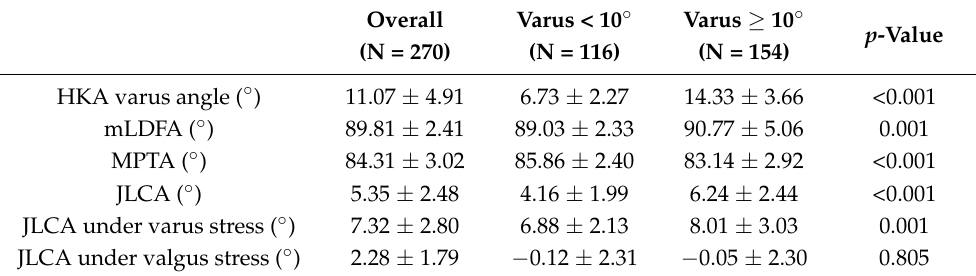
Results are reported as mean ± standard deviation unless otherwise indicated. Boldface text indicates a parameter that differed significantly between the two groups ( p < 0.05). HKA: Hip-knee-ankle; mLDFA: mechanical lateral distal femoral angle; MPTA: medial proximal tibia angle; JLCA: joint line convergence